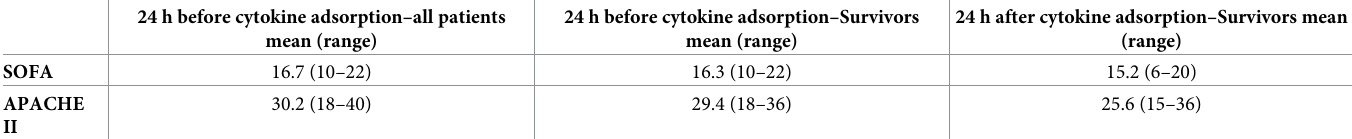
Table 5. Prognostic